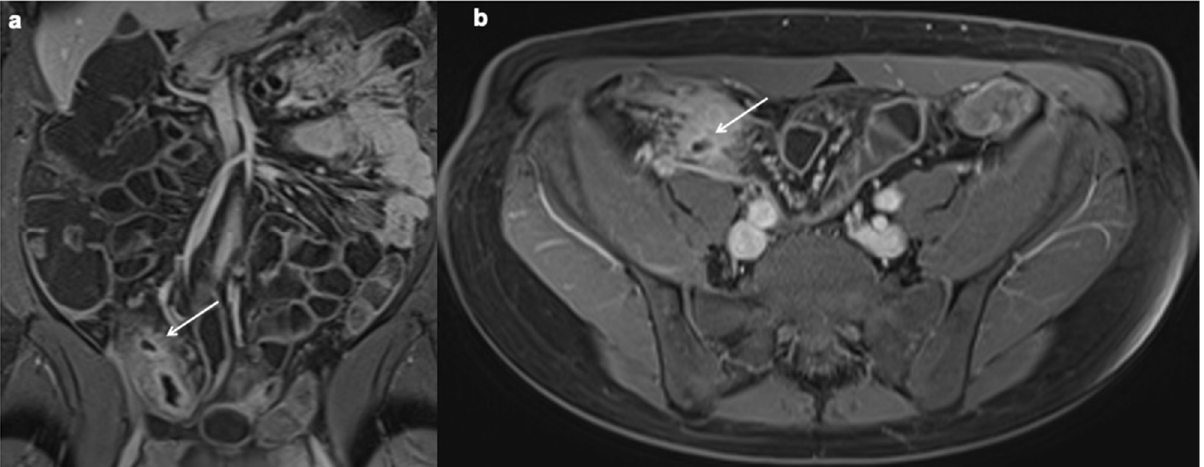
Figure 9. Sinus tract. Coronal and axial contrast-enhanced fat-suppressed T1 weighted portal venous phase ( a , b ) MRE images show a sinus tract that from the endoluminal side crosses the wall and extends beyond the serosa of the intestinal wall into the peri-visceral adipose tissue (white arrows). A fistula is a pathway that connects the intestinal lumen to another epithelialized sur- face and are named after the structures they connect, such as an enteroenteric,